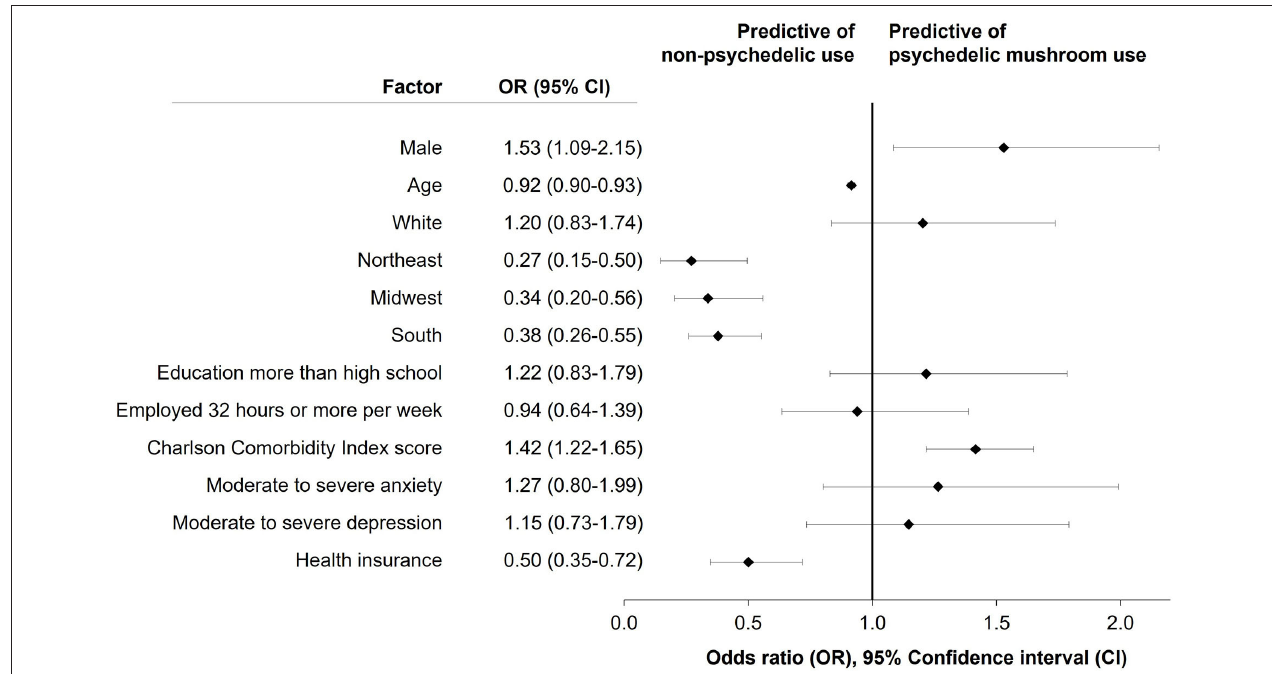
FIGURE 1 | Results of multivariate logistic regression model predicting past year psychedelic mushroom use for selected demographic and educational factors and health and comorbidity indicators.